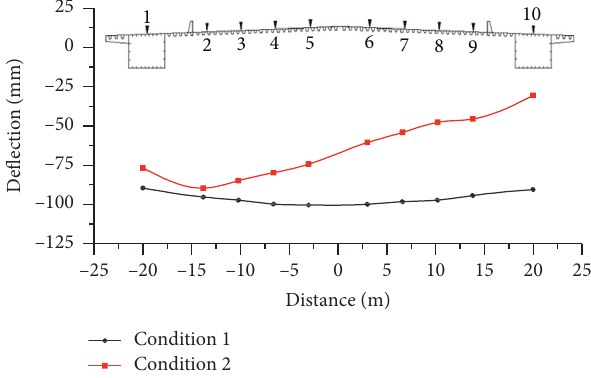
Figure 10: Lateral distribution of